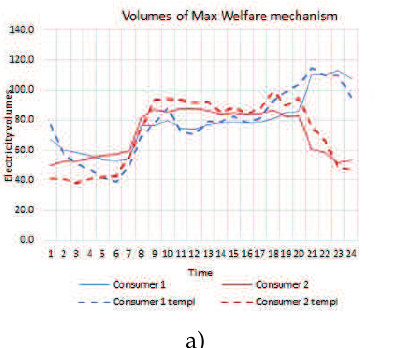
Figure 6. The maximum welfare pricing. The optimal load (a) and prices (b).